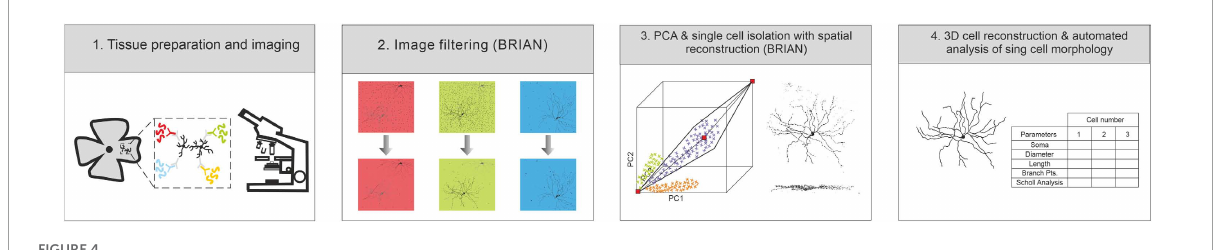
FIGURE4 Schematic of the main elements of the BRIAN platform: (1) Tissue preparation and imaging: (2) image pre-filtering and preparation [to remove uninformative voxels, including those with signal for only a single fluorophore (blue panel)], (3) PCA and single cell identification, and (4) 3D spatial reconstruction with automated single cell data